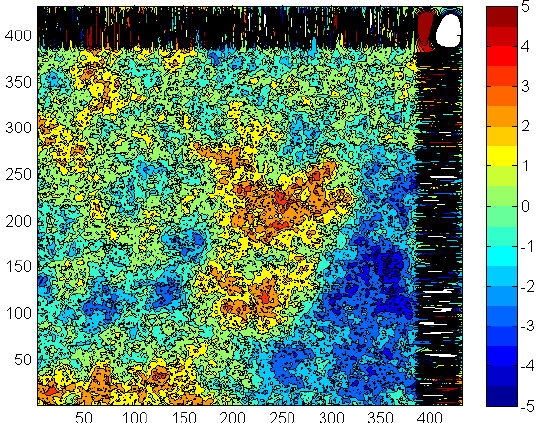
Figure 10. An arbitrary grid-point field with N xi = N yi = 432 and the extension zone width of 48 points, periodized with the HIRLAM